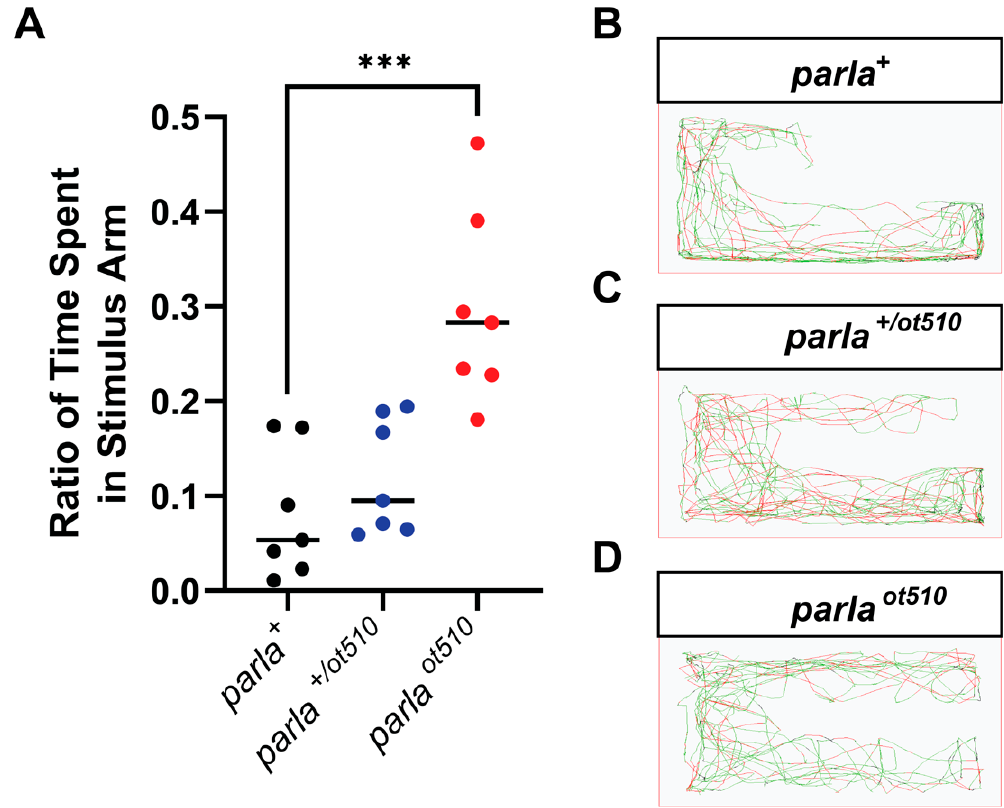
Figure 4. Decreased olfactory function in adult zebrafish with parla loss-of-function. ( A ) Ratio of time spent in stimulus arm of 7–12 mpf adult zebrafish ( n = 7). ( B – D ) Path images of a representative for WT fish ( parla + ), homozygous mutants ( parla ot510 ), and heterozygous mutants ( parla +/ot510 ). Bars represent the Median. *** ( p < 0.001).